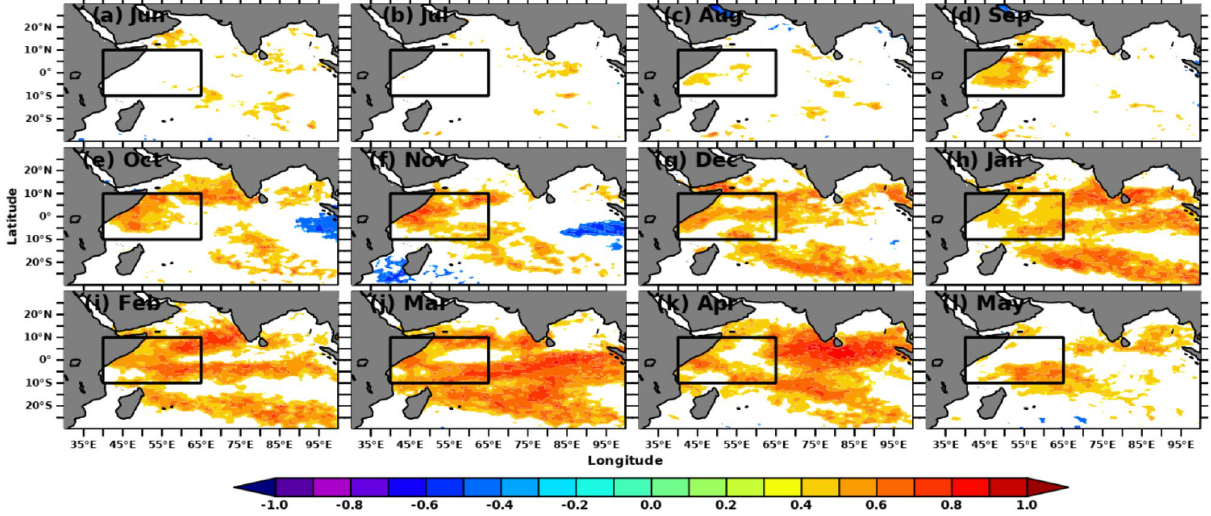
Figure 2. Simultaneous monthly correlations between detrended Indian Ocean SSTA and Nino3.4 SSTA indices. Areas of correlations at 95% significance are shown. The figure is generated using PyFerret